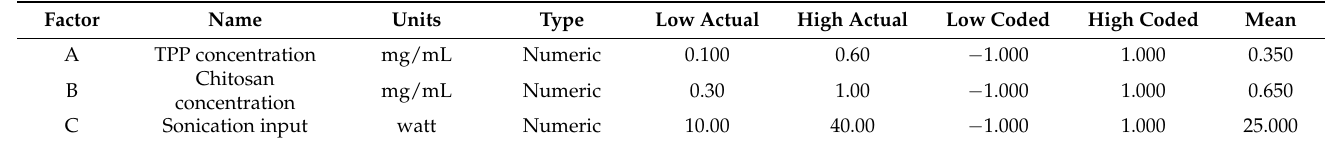
Table 3. Experimental design summary of independent variables.